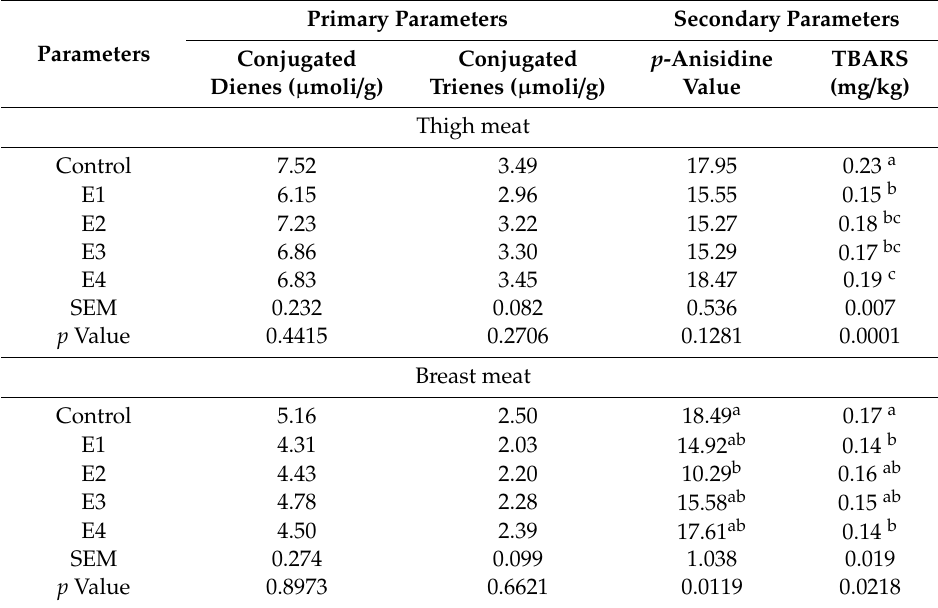
Table 5. The lipid degradation parameters of the broiler meat.